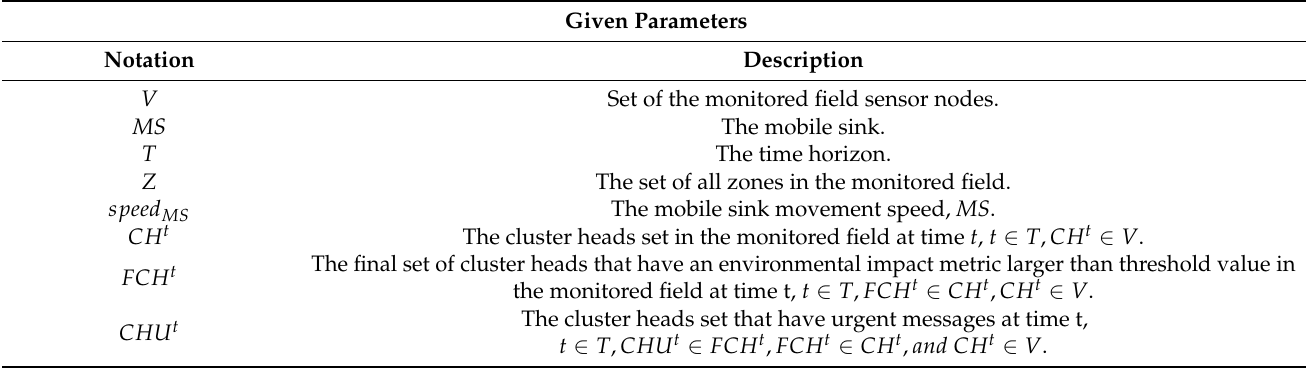
Table 3. The problems model